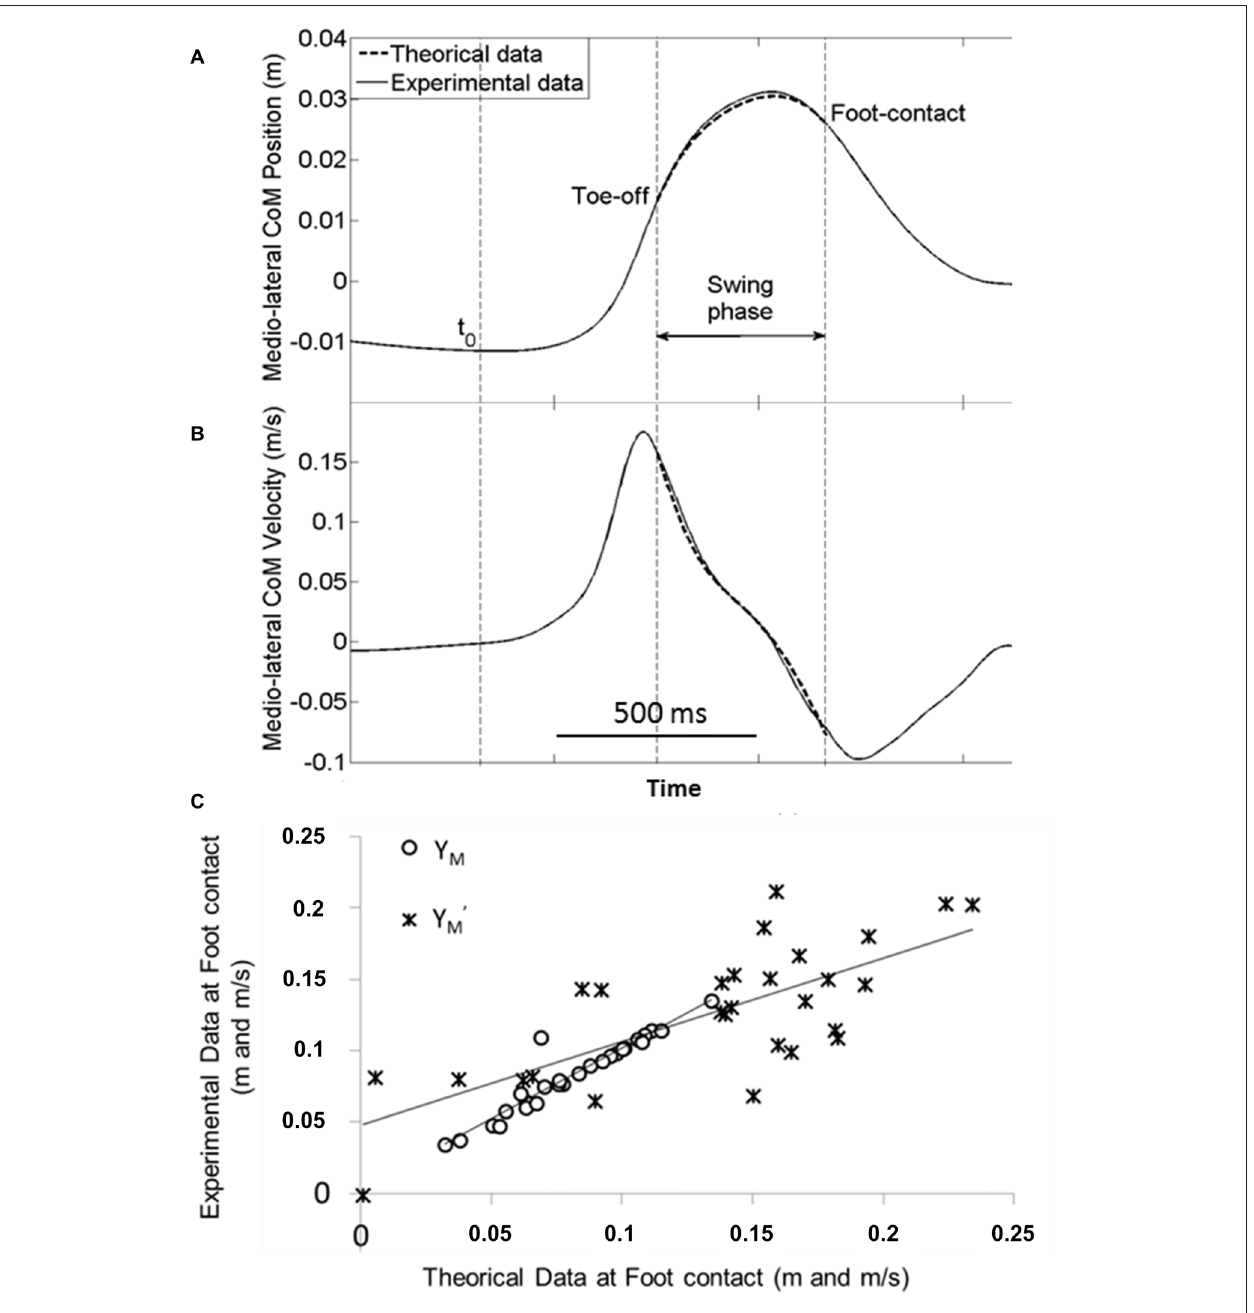
FIGURE 6 | Validation of the mechanical model. Typical experimental (full line) and theoretical (dash line) time-course traces of the ML center of mass shift (A) and velocity (B) are superimposed during the swing phase (from swing foot off to foot contact). Traces are obtained from one representative subject in the reaction-time condition with the medium height and short distance obstacle. (C) Example of linear regression between experimental vs. theoretical data obtained in the obstacle free (control) condition. Each point represents the average value of the ML center of mass position (Y M ) and velocity (Y (cid:48) M ) at foot contact in the control conditions (self-initiated and reaction-time conditions pooled together) for each of the 14 subjects. Note the excellent fit between the experimental and theoretical